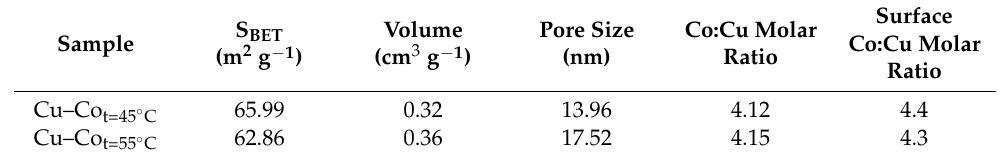
Table 1. BET surface area, BJH mean pore size, pore volume, and elemental composition of catalysts.